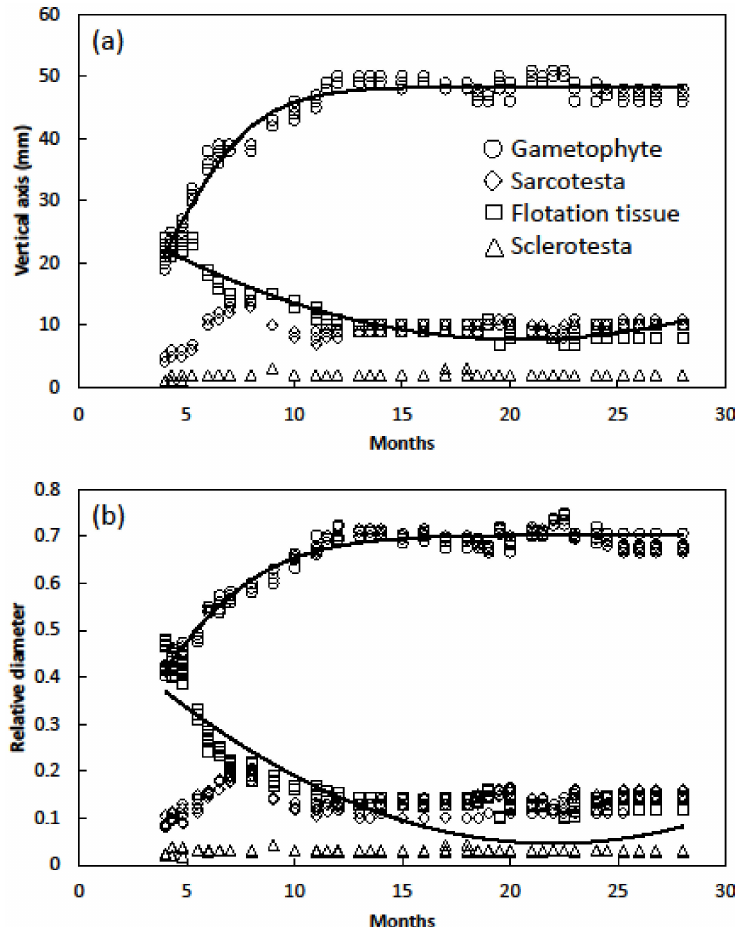
Figure 7. Longitudinal dimensions of Cycas micronesica seed tissue categories from 4 to 28 months in age. ( a ) Absolute diameter. Gametophyte: y = 48.331 / (1 + exp(2.301 − 0.522x)), p ≤ 0.001, r 2 = 0.96; Flotation tissue: y = 29.99 − 2.17x + 0.0.05x 2 , p ≤ 0.001, r 2 = 0.91; ( b ) The proportion of longitudinal dimension. Gametophyte: y = 0.703 / (1 + exp(1.124 − 0.373x)), p ≤ 0.001; r 2 = 0.95; Flotation tissue: y = 0.53 − 0.04x + 0.001x 2 , p ≤ 0.001, r 2 =